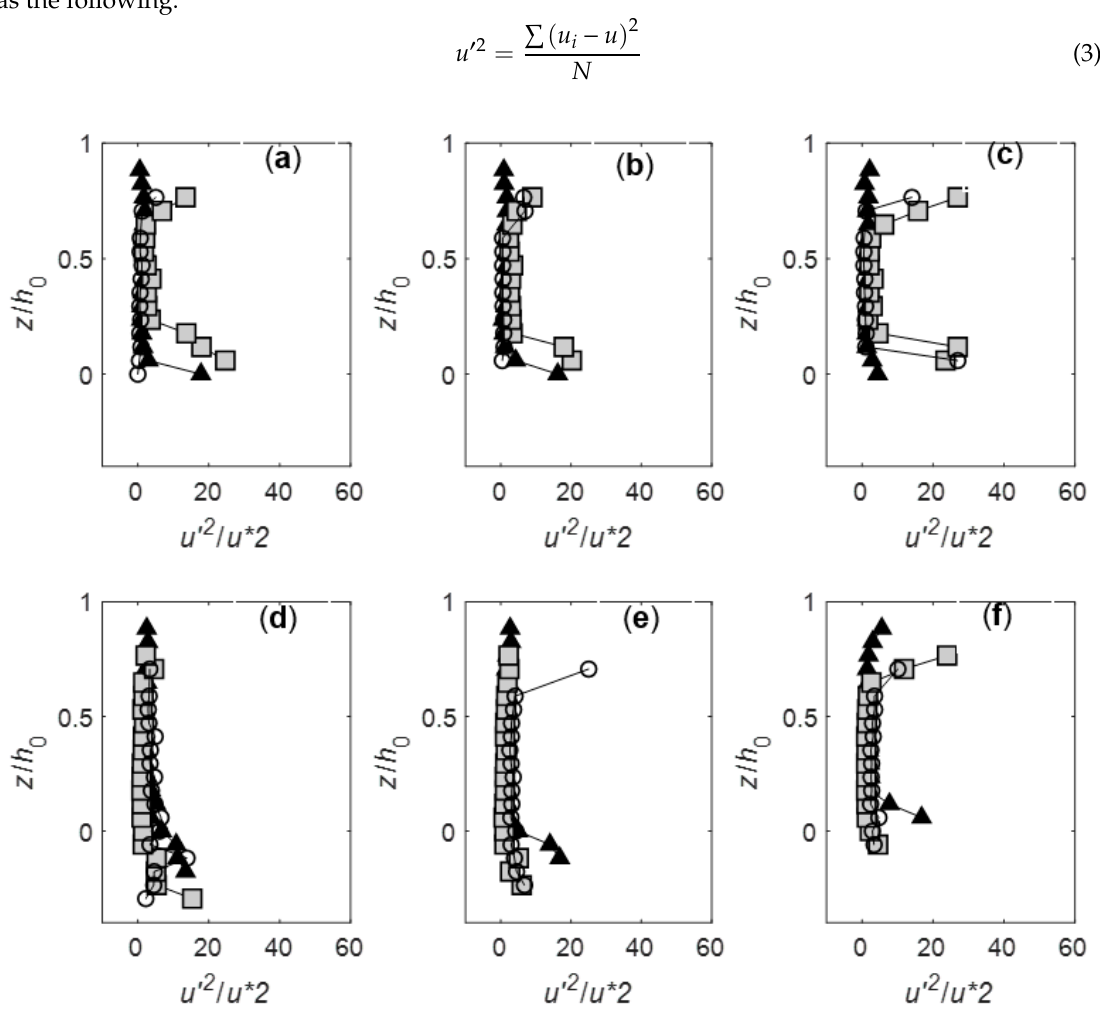
Figure 5. Comparison of longitudinal velocities turbulence intensity for three different verticals, ( a , d ) y / D = 0.833, ( b – e ) y / D = 1.5, and ( c – f ) y / D = 4.2, for fixed (top rows) and mobile beds (bottom rows). Symbols are the same symbols as in Figure 2.